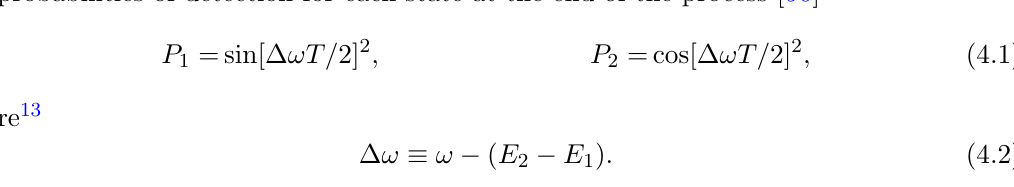
1 ( 2 ). During the Ramsey time T the atoms can interact | (cid:30) | (cid:30)